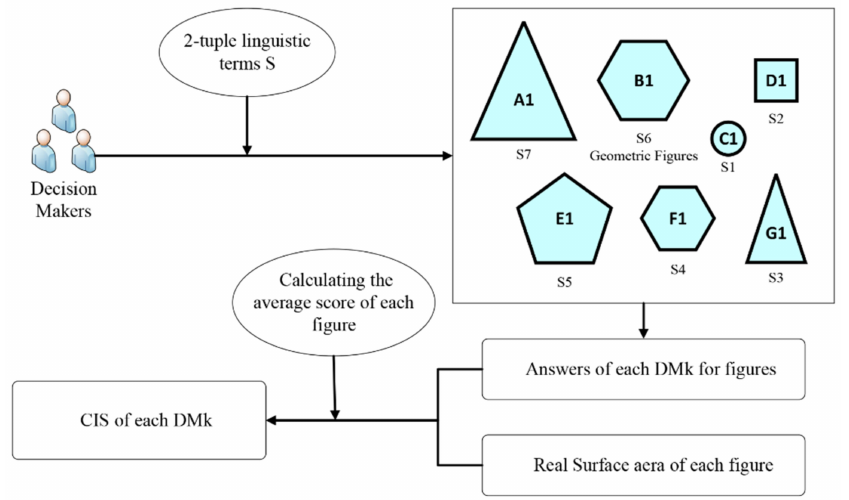
Figure 2. The basic framework of CIS